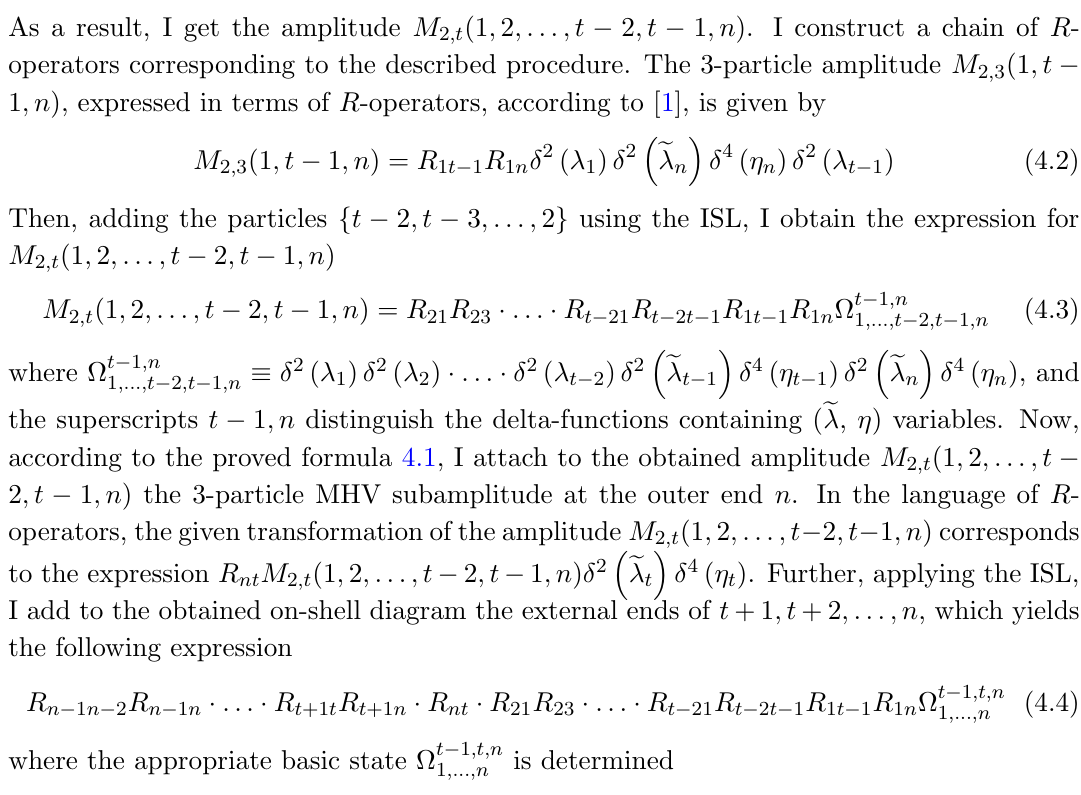
Figure 2 . A diagrammatic representation of eq.